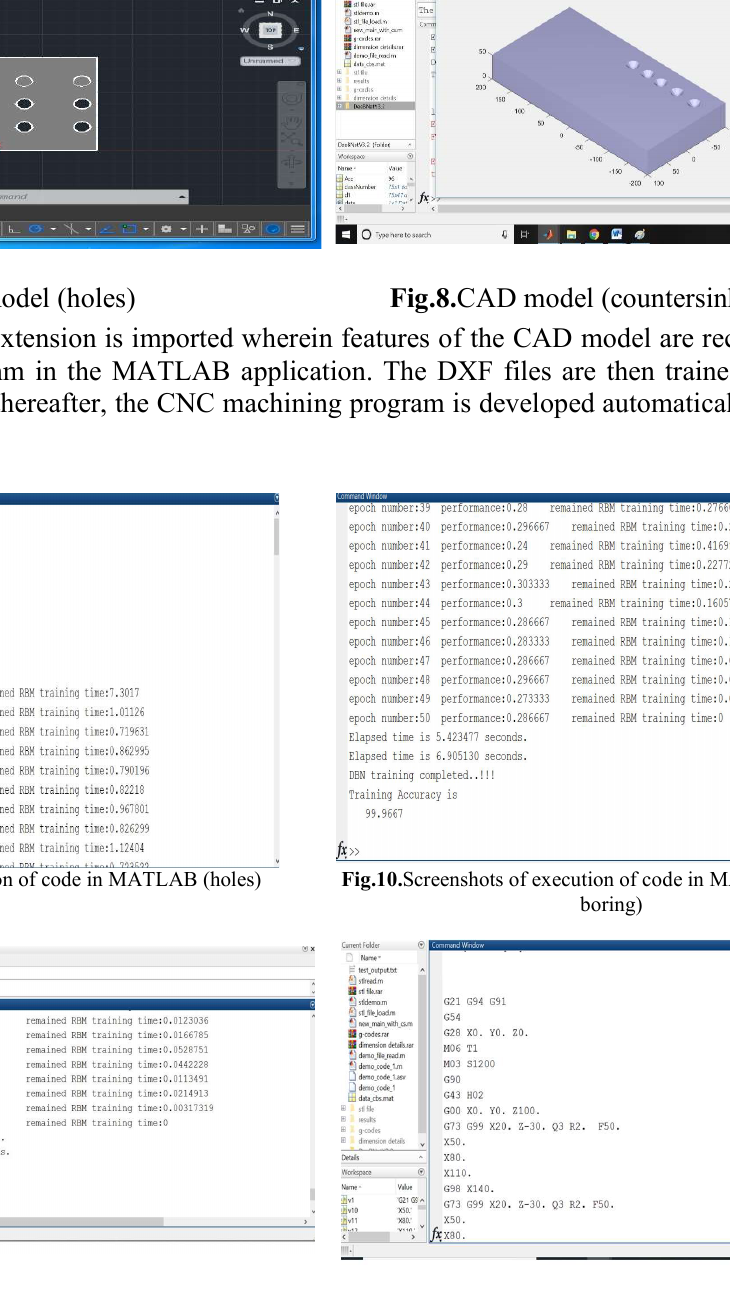
Fig.12. Screenshots of Automatic program for CNC ma-